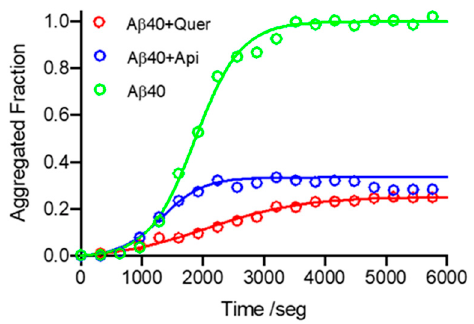
Figure 3. Time-course kinetics of A β 40 aggregation in the absence and presence of quercetin and apigenin, followed by ThT fluorescence. Green: without flavonoid; blue: with apigenin; red: with quercetin. Conditions: [Quercetin/Apigenin] = 20 µ M; [A β 40] = 20 µ M. Table 1. Kinetic parameters obtained for the aggregation of free A β 40, and upon incubation with apigenin and quercetin.